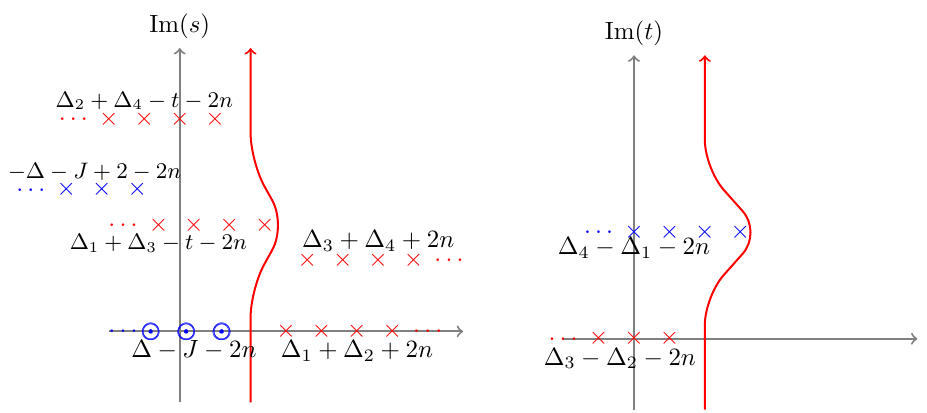
Figure 3 . Poles in the complex s and t planes. We have complexi(cid:12)ed the scaling dimensions here for the purposes of